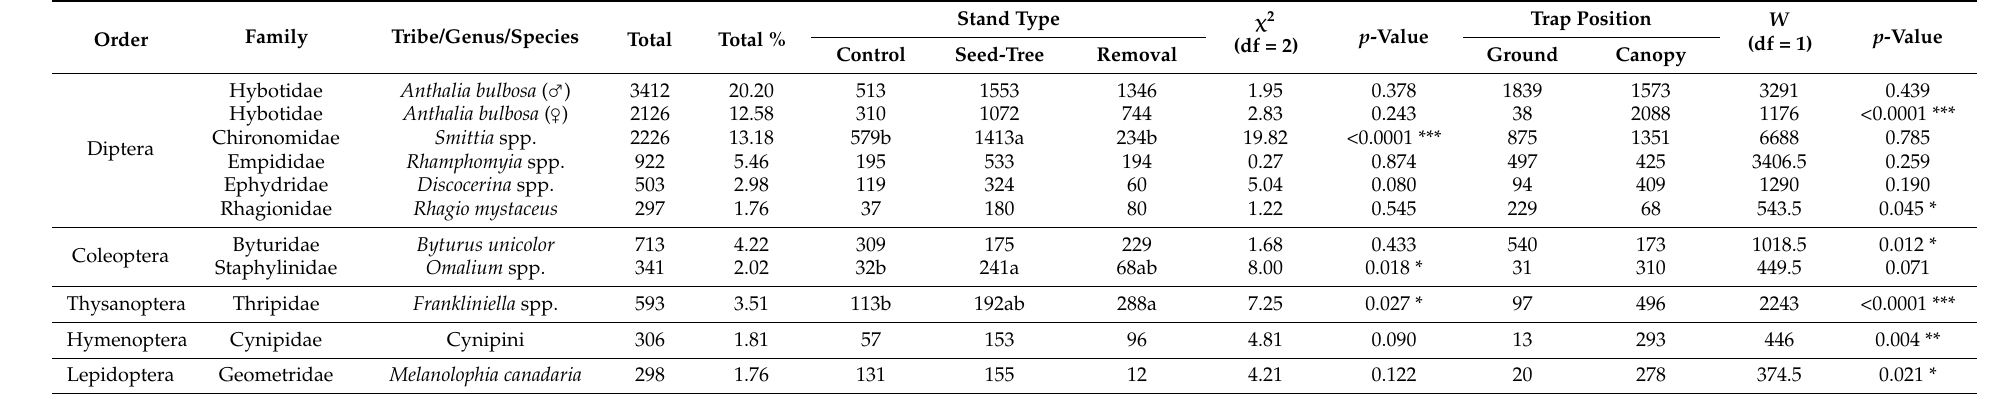
Table 2. List of the 11 most abundant morphospecies (10 species) captured in different stand types of forest management (control, seed-tree, and removal) at two positions (ground and canopy). Captures of each morphospecies by the three treatments (control, removal, and seed-tree) were analyzed by Kruskal–Wallis test with Chi-Square approximation. Dunn test was used for pairwise comparison with p -values adjusted by Benjamini-Hochberg procedure, while different letters within species indicate significant differences among stand types (Adj. p < 0.05). Captures by the two trap positions were analyzed by Wilcoxon rank-sum test